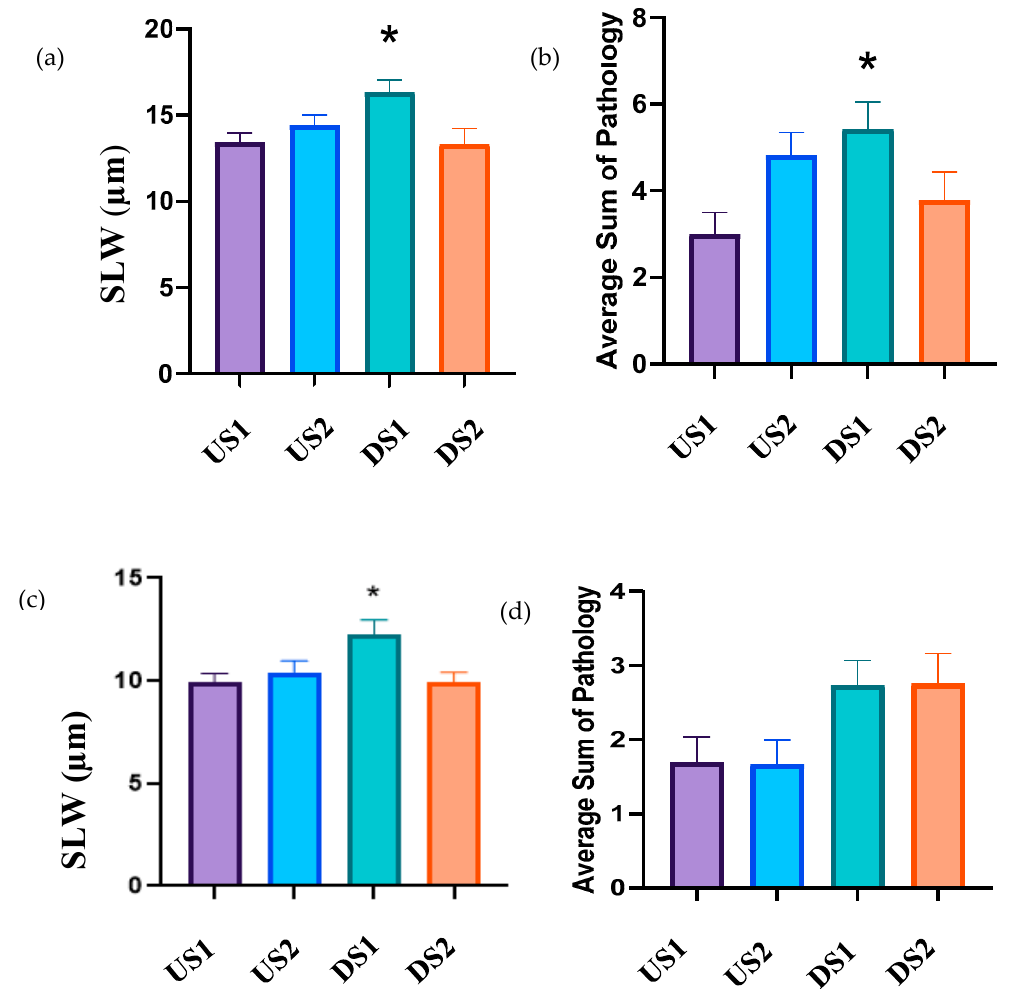
Figure 4. ( a ) Secondary lamellar width / diameter (SLW) of the RBDs in fall 2013 / 2014. ( b ) Pathology scores of the RBDs in fall 2013 / 2014 ( p < 0.05, n = 8, 18, 16, 15). ( c ) SLW of the RBDs in summer 2019. ( d ) Pathology scores of the RBDs in summer 2019 ( p < 0.05, n = 9, 11, 14, 11). An asterisk represents a significant di ff erence compared to US1 using a one-way ANOVA and Dunnett’s multiple comparisons test. RBD, rainbow darter; US1, upstream 1; US2, upstream 2; DS1, downstream 1; DS2, downstream